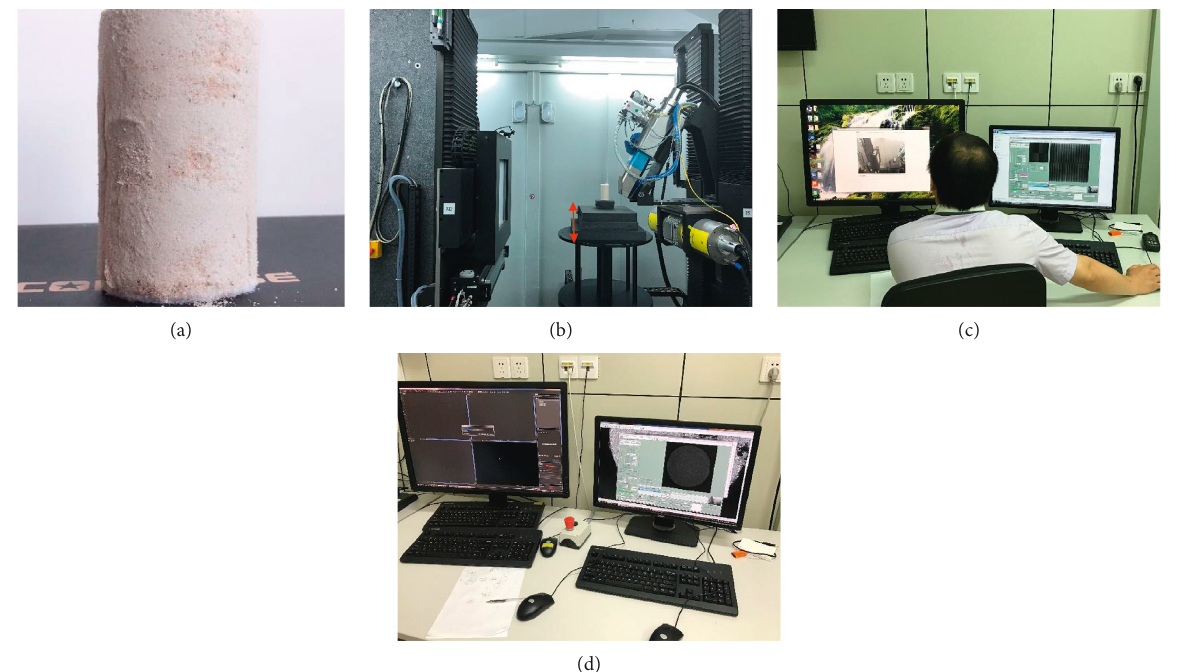
Figure 3: The micro-XCTexperimental process [13]: (a) test sample selection; (b) placing and adjusting the sample position; (c) setting the parameters and scanning the sample; (d) feature extraction.